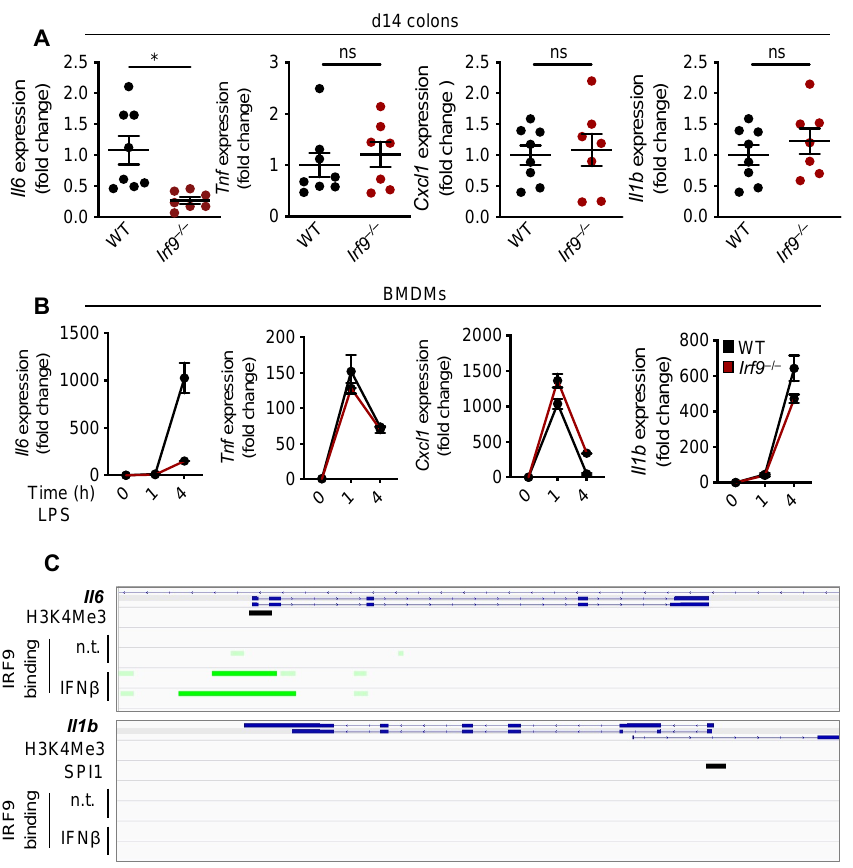
Figure 4. IRF9 regulates IL-6 transcription. ( A ) Transcript expression of Il6 , Tnf , Cxcl1 ( Kc ), and Il1b in the colon tissues of wild type (WT) (n = 8) and Irf9 − / − (n = 7) mice14 days after AOM injection and ( B ) in LPS-stimulated WT and Irf9 − / − bone marrow-derived macrophages (BMDMs) at 1 and 4 h post-stimulation. ( C ) ChIP-Seq analysis of IRF9 binding to the Il6 (top) and Il1b (bottom) promoter. Green highlights the IRF9 binding site. Each symbol represents an individual mouse in ( A ). ns, not statistically significant. * p < 0.05. Two-way ANOVA was used in ( A ). Data are represented as mean ± SEM in ( A , B